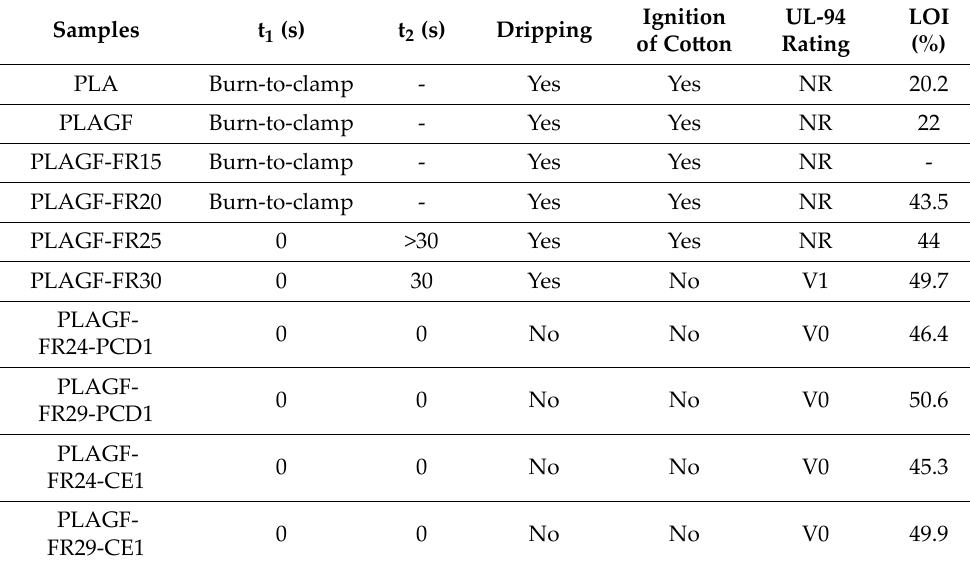
Table 5. UL‑94 vertical burning and LOI results of PLA and PLA